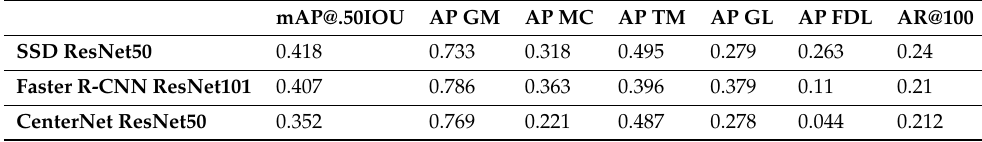
Table 3. Model-centric results of best model architectures on test